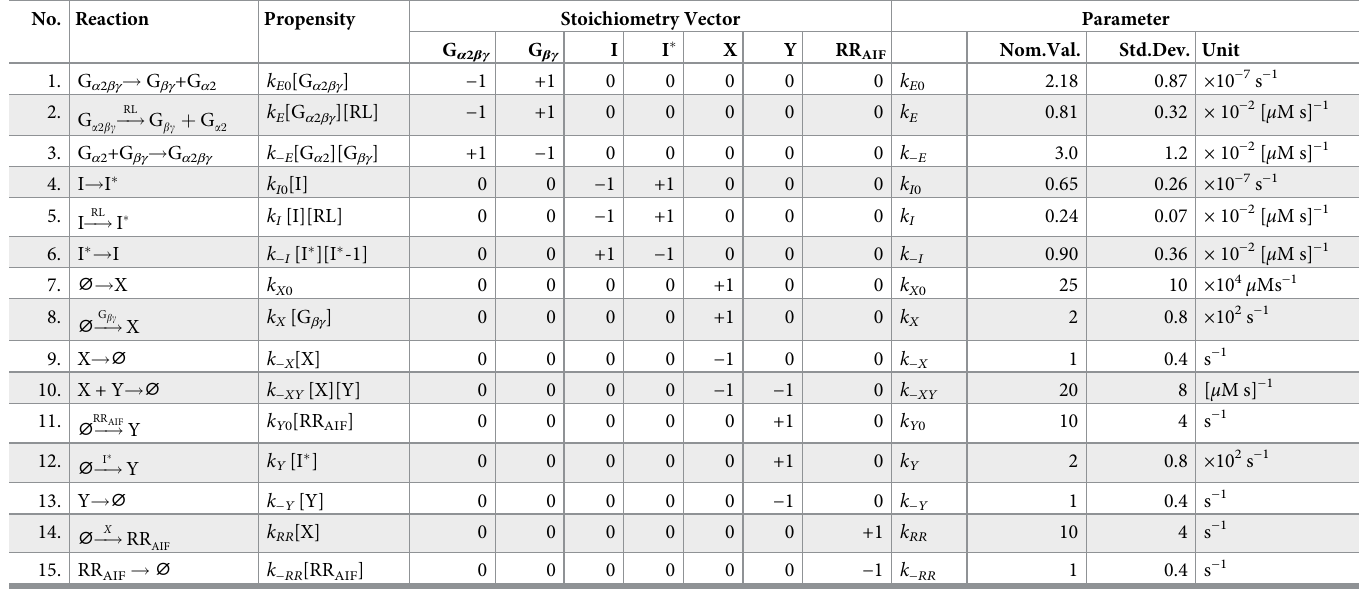
Table 3. Parameters for LEGI modules. RL is the total occupied receptors (H:C + L:C + S:C + P H:C + P L:C). The reactions no. 7–15 are for only AIF scheme of LEGI mechanism. The nominal values for the diffusion constants are: D sion constants were chosen to be 20% of the respective nominal values. Further details are in S1 File. No.